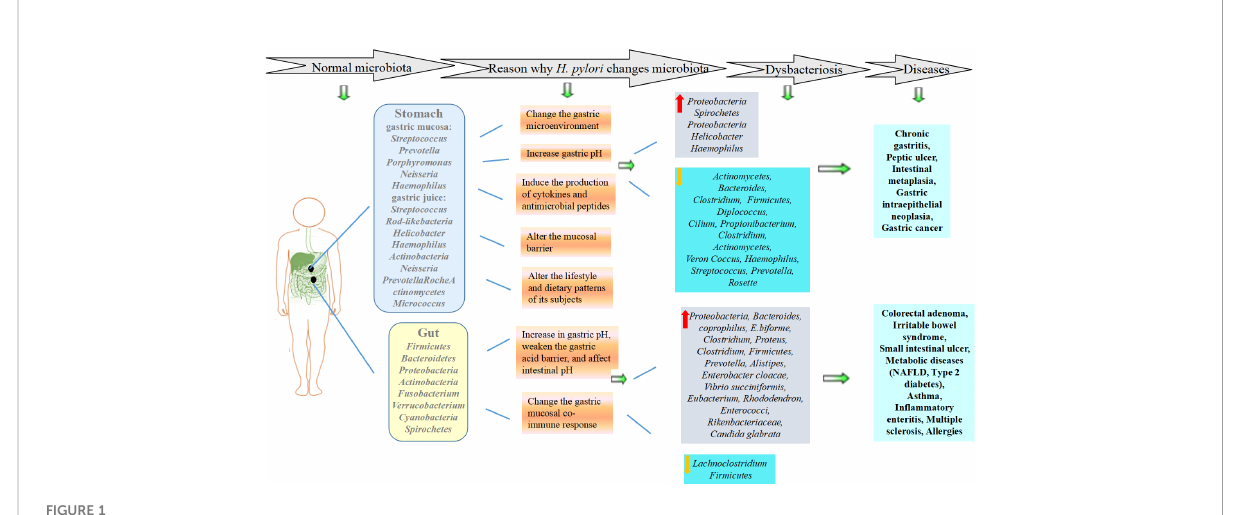
FIGURE 1 Effects of H. pylori infection on gastrointestinal microecology and